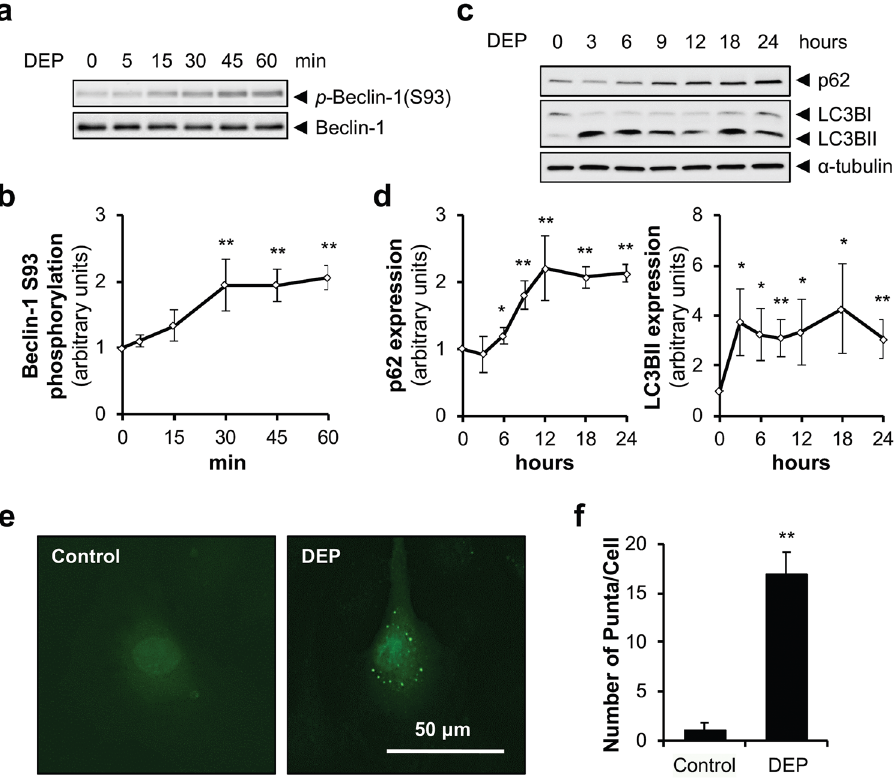
Figure 2. DEP initiate autophagy in HUVECs. ( a ) HUVECs were exposed to DEP (70 µg/ml) for the indicated times and phosphorylation of Beclin-1 at Ser93 was analyzed by immunoblotting. ( b ) Quantification of Beclin-1 phosphorylation normalized to total Beclin-1. Results are presented as means ± SD (n = 3). Statistical analysis was performed using one-way ANOVA. **P < 0.02 versus no treatment. ( c ) HUVECs were exposed to DEP (70 µg/ml) for the indicated times and protein levels of p62 and LC3B were measured by immunoblotting. ( d ) Quantification of p62 and LC3BII protein levels normalized to ⍺ -tubulin. Results are presented as means ± SD ( n = 3). Statistical analysis was performed using one-way ANOVA. * P < 0.05 versus no treatment. **P < 0.02 versus no treatment. ( e ) HUVECs infected with GFP-LC3B-expressing adenovirus were exposed to DEP (70 µg/ ml) for 18 h and formation of LC3B puncta was examined with fluorescence microscopy. ( f ) Quantification of LC3B puncta formation per cell. Results are presented as means ± SD ( n = 10). Statistical analysis was performed using two-tailed Student’s t test. **P < 0.02 versus